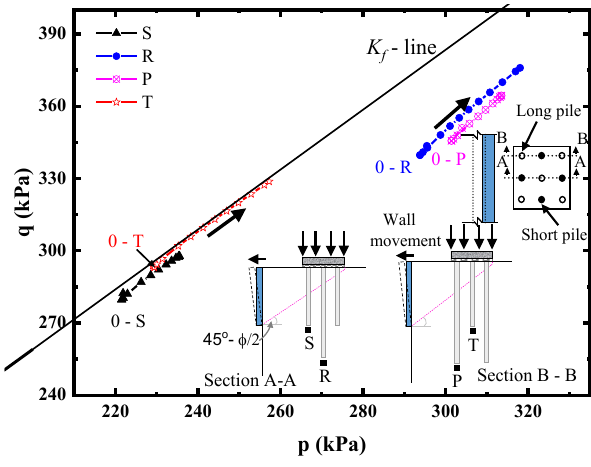
Figure 13: Response of soil element beneath the pile toe during wall movement (e.g., 0-S indicates initial stress state before wall movement for element S).